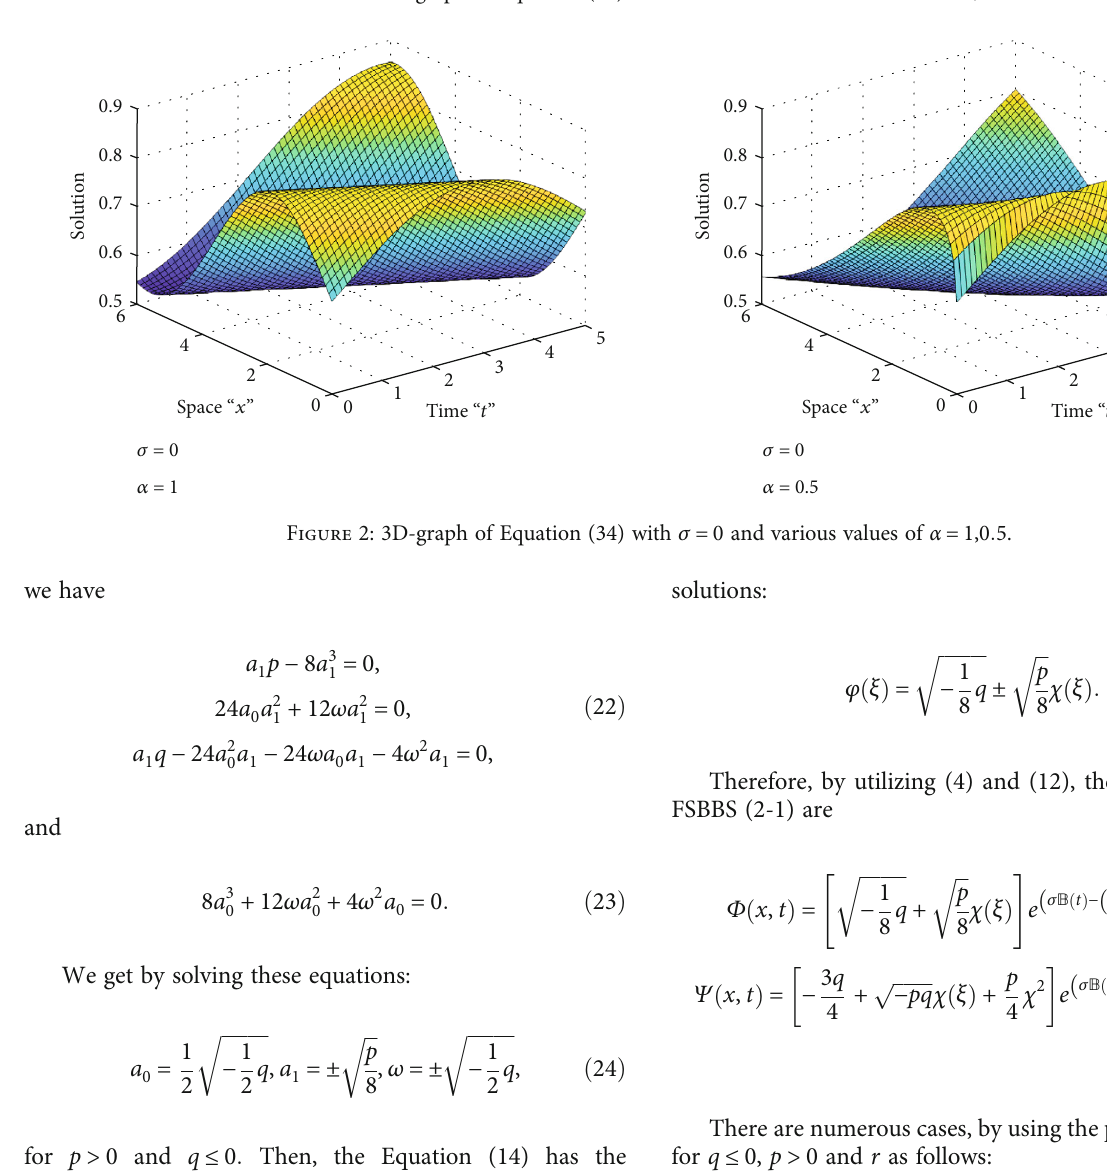
Figure 1: 3D-graph of Equation (33) with σ = 0 and various values of α = 1,0 : 5 :